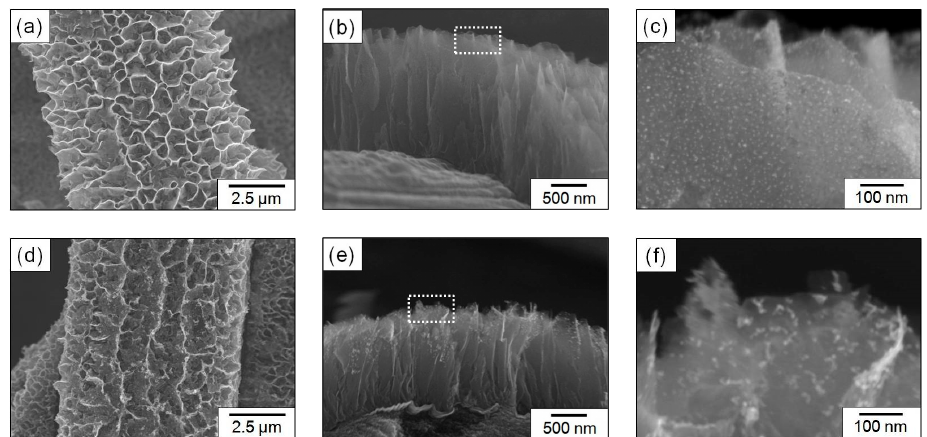
Figure 1. SEM images of ( a ) top view, ( b ) cross-sectional view, and ( c ) magnified view of edges of Pt-